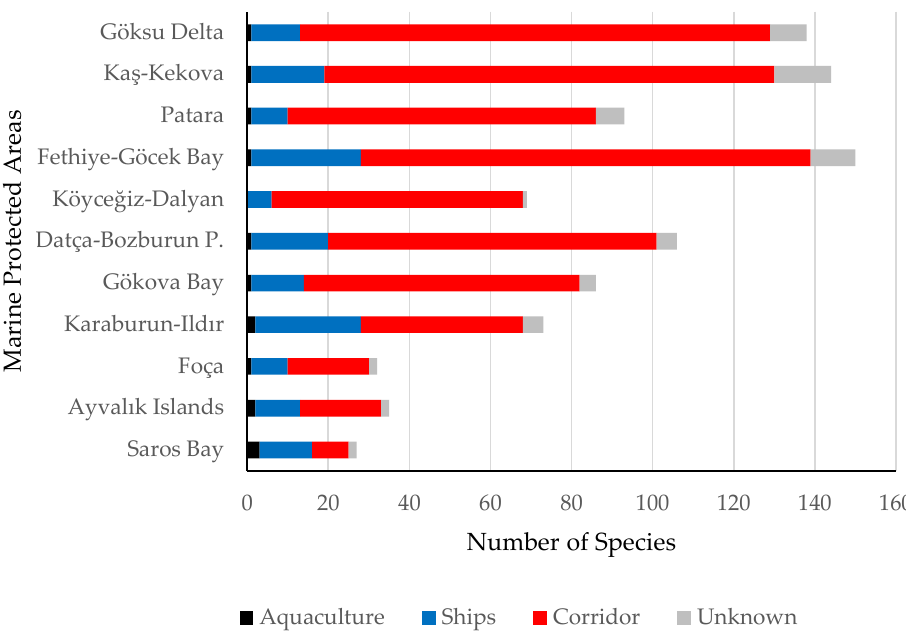
Figure 5. Pathways of the introduction of alien taxa in MPAs.